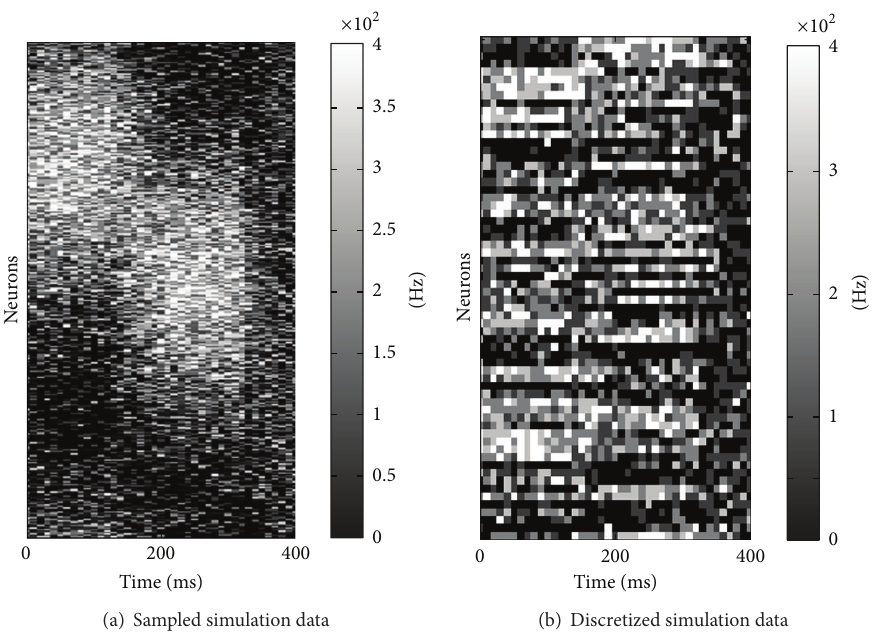
Figure 4: Representation of sampled and discretized simulation data. 64 random neurons were sampled from virtual ensemble data with 512 neurons (a) and then discretized in a 10 ms resolution (100Hz) (b). Stimulation direction was 0.5𝜋 for the first 120 ms and 𝜋 for the next 240 ms.